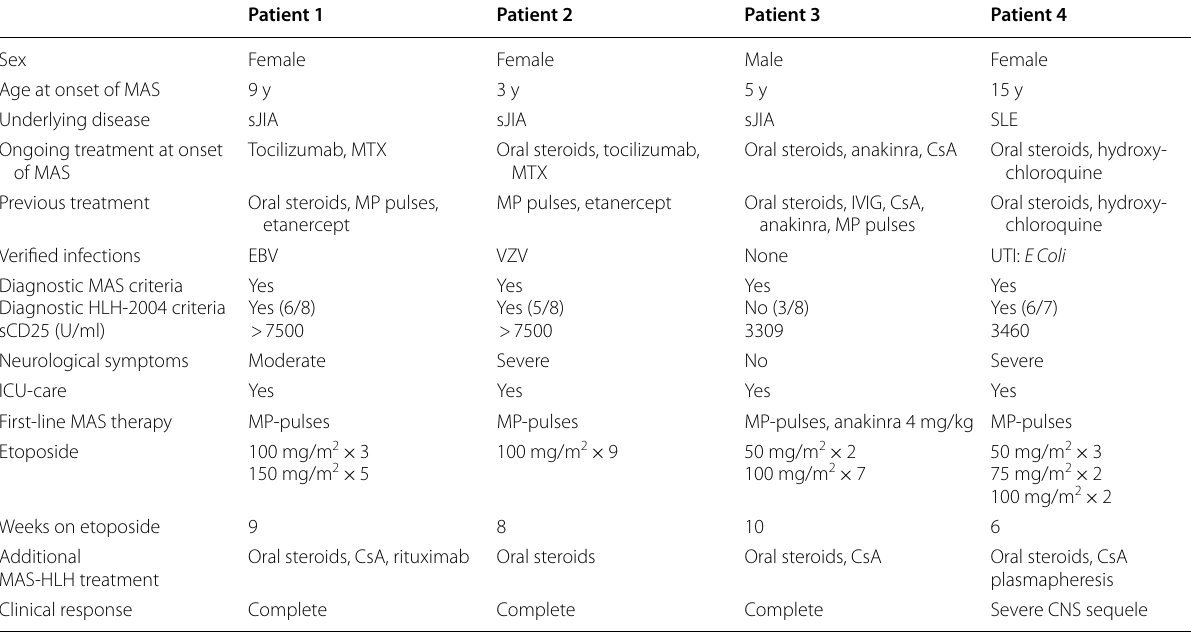
Table 1 Clinical characteristics of the four children with